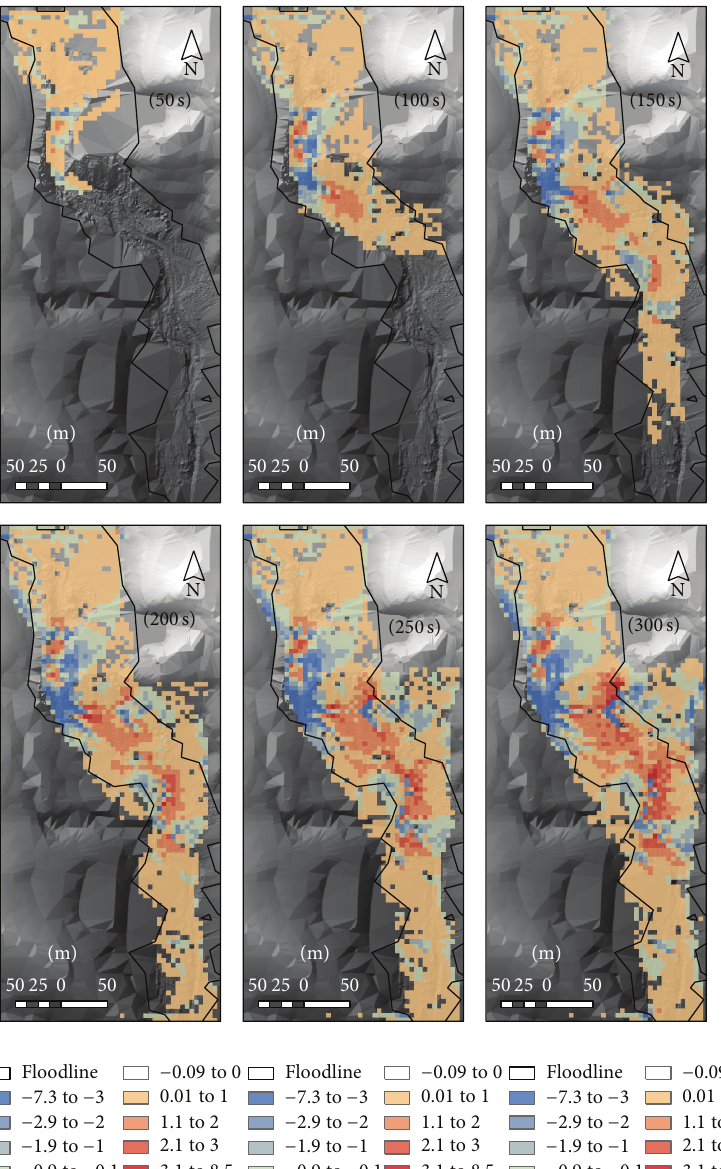
Figure 9: The temporal progression of the simulated debris